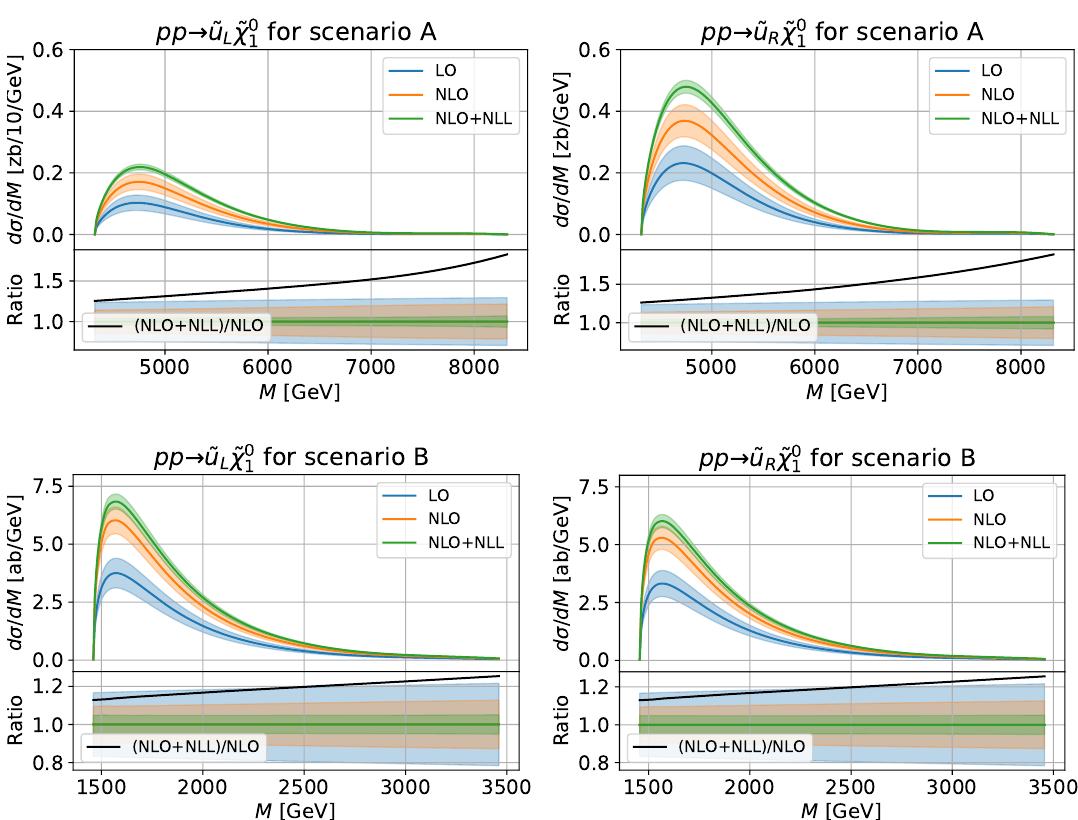
Figure 4. Invariant-mass distributions for the processes pp → ˜ u L,R ˜ χ 0 certainties correspond to variations around the central scale µ 0 = M , and we additionally show NLL+NLO/NLO K -factors (bottom panels). The results are shown for both scenarios A and B with MSHT20 PDFs and a centre-of-mass energy of